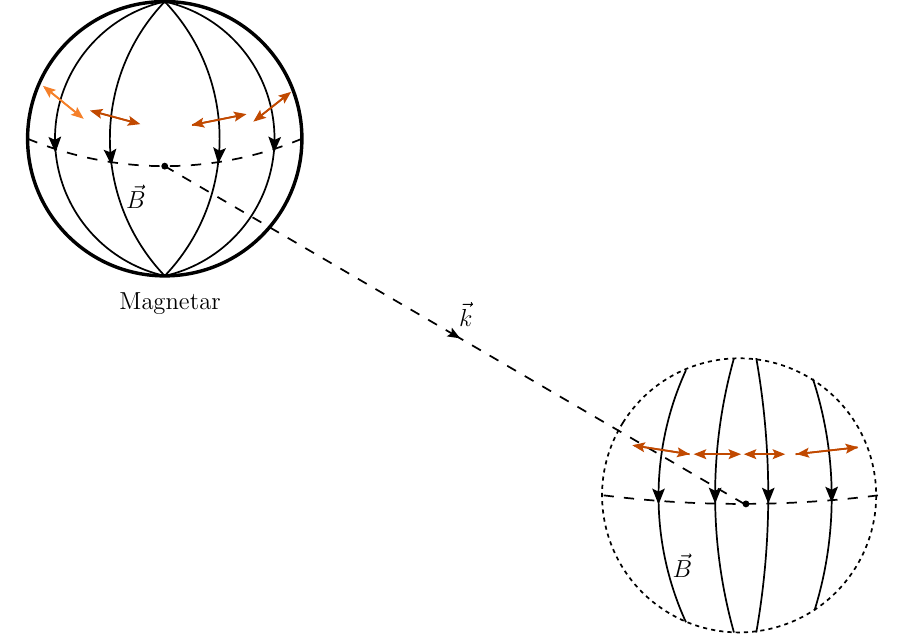
Fig. 1 It is assumed that, on the magnetar, light is always polarized in a plane orthogonal to the magnetic field at a given point, and to the wave vector k . All distinct sources are seen as superimposed by the dis- tant observer, resulting in a faint polarization. Far away from the star, as long as B is still appreciable, the curvature of the surface tangent to the magnetic field vectors (spherical cap) is smaller: magnetic field